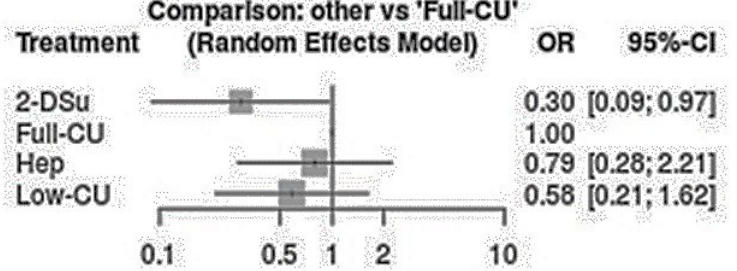
Figure 6. Intervention regarding the anticoagulant protocols compared to continuous full coumarins therapy.